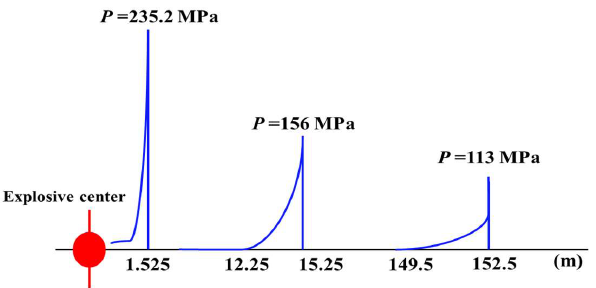
Figure 8. Data regularity curves of shock wave disseminating experiment tested in water.